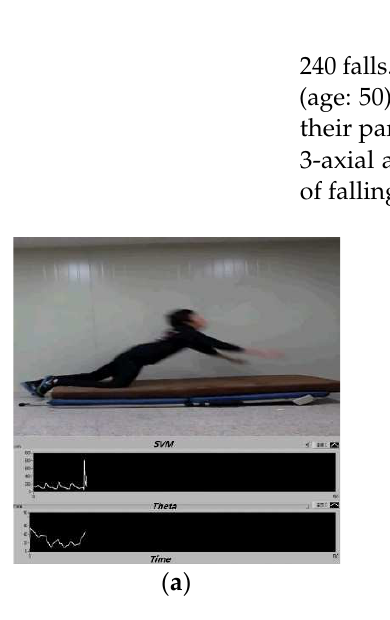
Figure 2. Photos performing 3 types of fall and their measured parameters, sum vector magnitude ( SVM ) and angle (Theta; θ ). ( a ) Falling forward, ( b ) Falling sideway, ( c ) Falling backward.